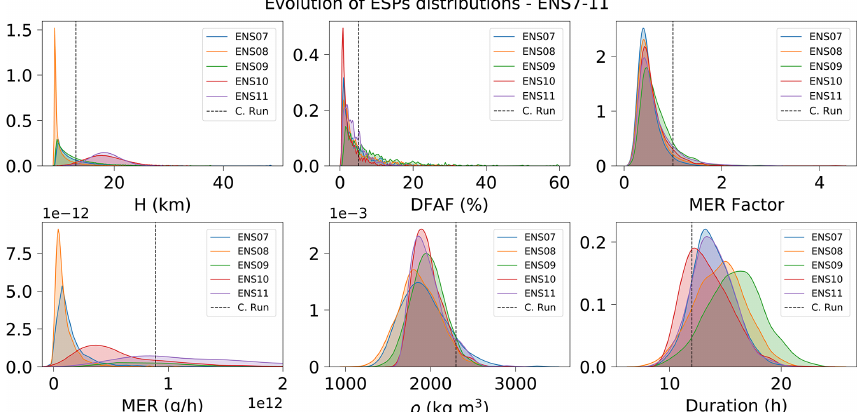
Figure B1. Evolution of ESPs distributions for ENS07 (blue shading), ENS08 (orange shading), ENS09 (green shading), ENS10 (red shading), and ENS11 (purple shading). Each panel shows (a) plume height ( H ), (b) distal fine ash fraction (DFAF), (c) mass eruption rate factor (MERF), (d) mass eruption rate (MER), (e) ash density ( ρ ), and (f) eruption duration. For ENS07–11, each parameter is sampled from posterior pdfs (see the main text for a detailed description of the re-sampling method). The mass eruption rate (MER) is shown for all the ensembles, but it is not explicitly perturbed. Dashed black lines in each plot represent the parameter value used for the control run (see Table 1).